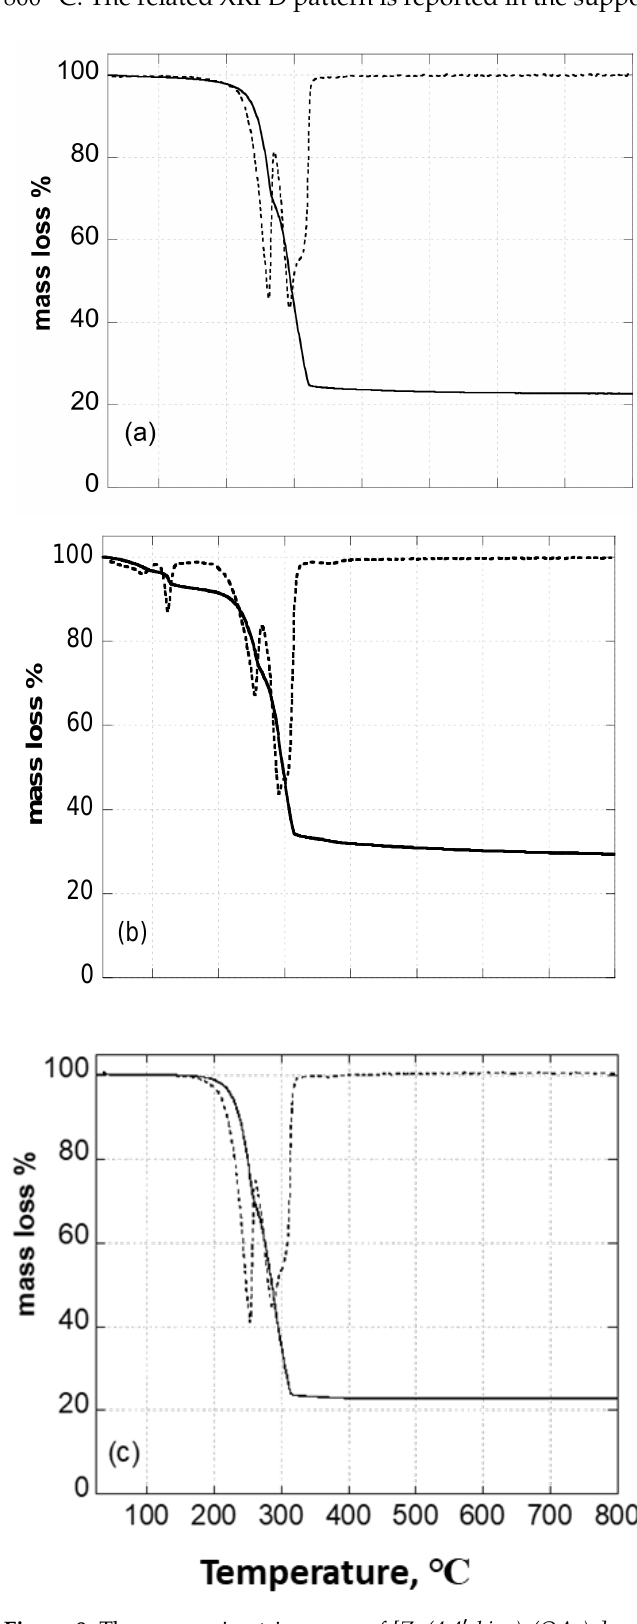
Commented [M4]: More clearer version